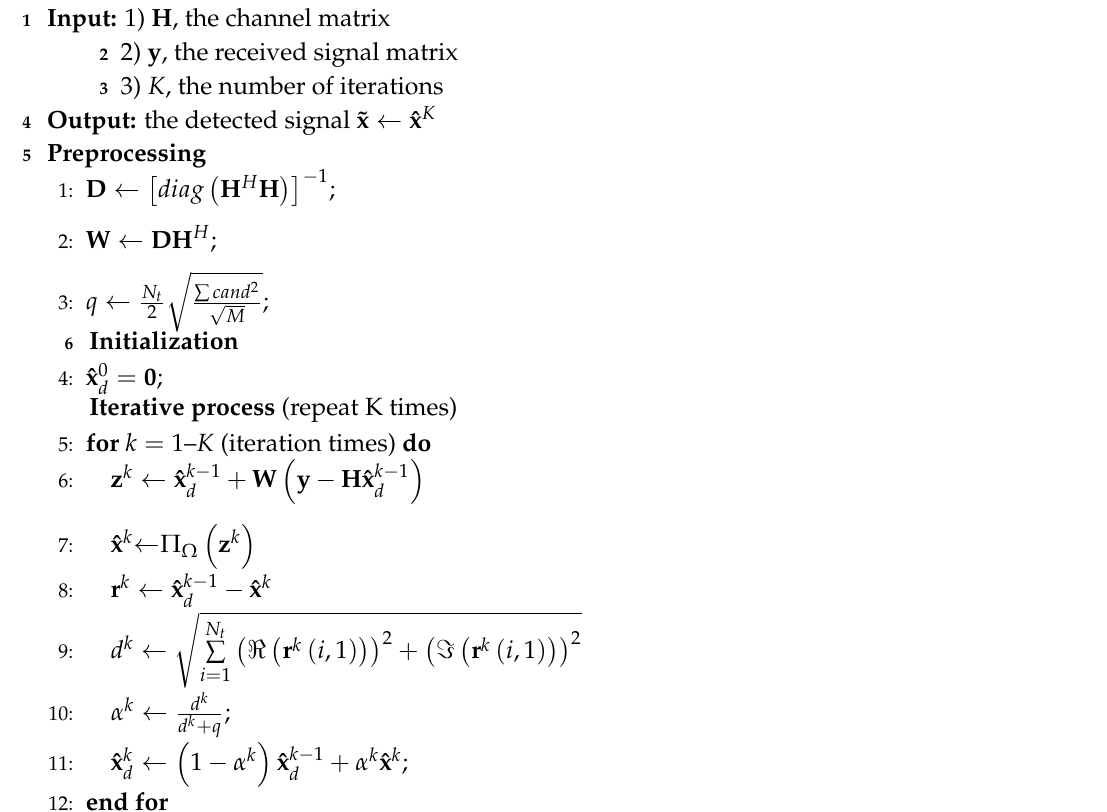
Algorithm 1: The pseudocode of the MIDE detection